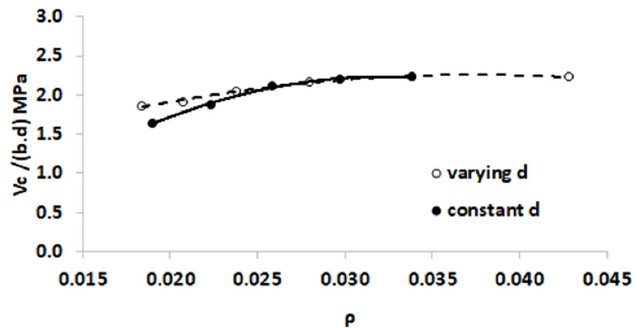
Figure 15. The effect of ρ due to ‘varying d’ and ‘constant d’ on the shear strength of concrete.